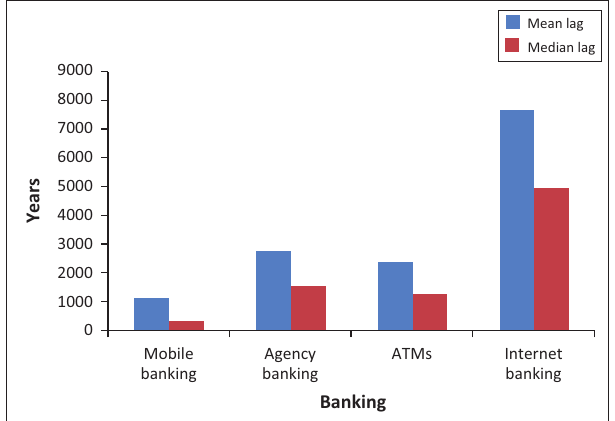
FIGURE 4: Financial innovation speed of adjustment to macro-level